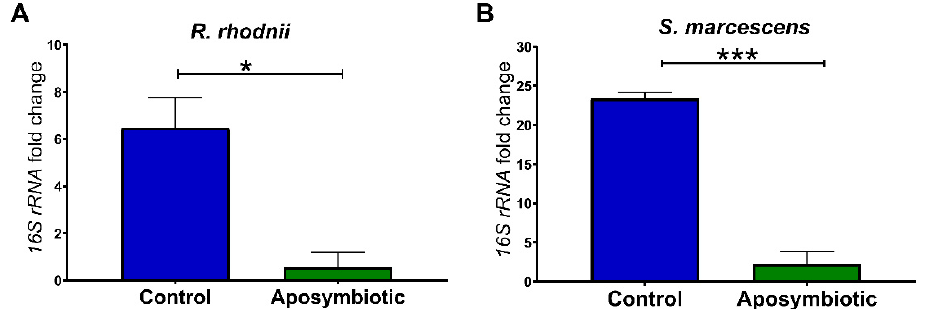
Figure 2. Determination of bacterial load in the anterior midgut of 1st instar nymphs of Rhodnius prolixus 5 days after feeding. Relative abundance of ( A ) R. rhodnii 16S rRNA (and ( B ) S. marcescens 16S rRNA. Treatments: Control group: eggs and insects kept in contact with adult feces; Aposymbiotic group: eggs treated with povidone-iodine 1% and maintained in sterile conditions. Each bar represents the mean of relative quantification (RQ) values of 2 experiments, each experiment with 2 pools of 5 insect tissues each, corresponding to 20 insects ( n = 4). The relative quantification by the ∆∆ Ct method was performed using the relative abundance of 18S rRNA of R. prolixus as the calibrator. ΔΔ Ct values were analyzed by an unpaired Student’s t -test, * p < 0.05; *** p < 0.001.